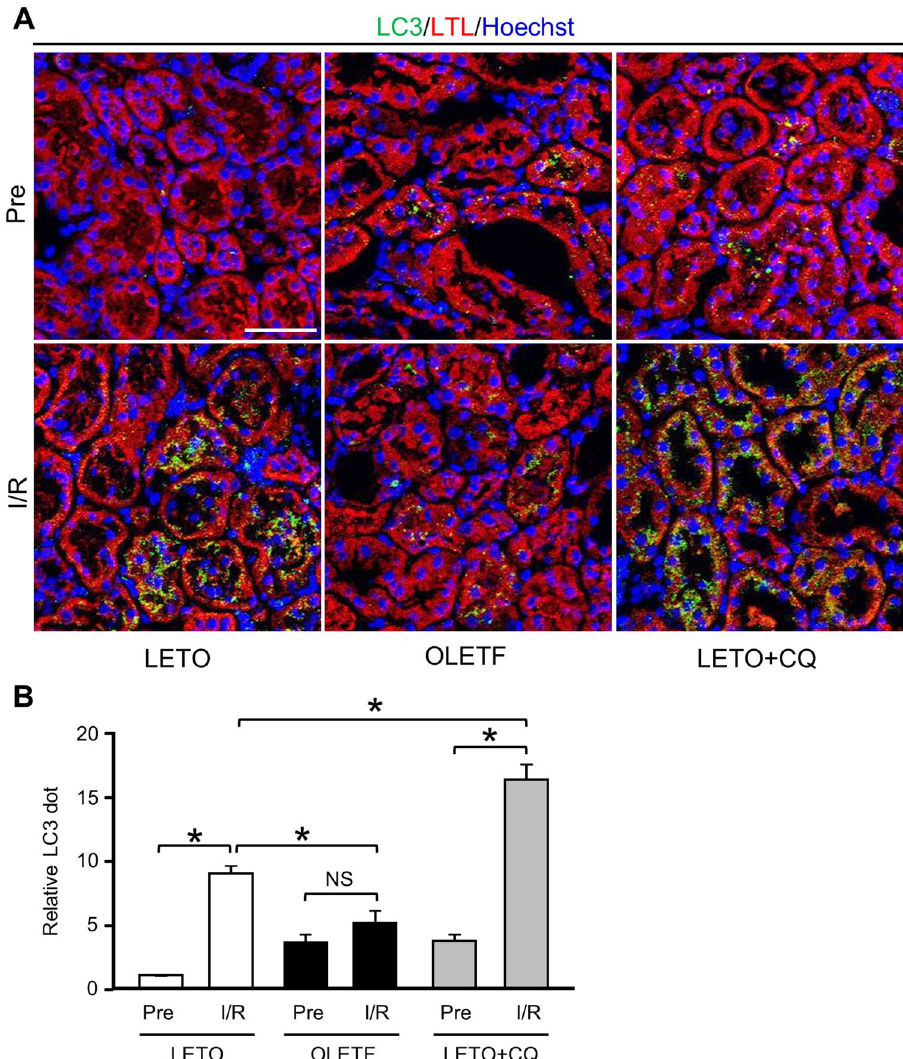
Figure 2. Autophagic response in proximal tubular cells after ischemia/reperfusion was attenuated in OLETF. ( A ) Representative immunofluorescence images of LC3 (green) and the proximal tubular marker lotus tetragonolobus lectin conjugated with Texas Red (LTL; red) in the kidneys of LETO, OLETF, and LETO treated with chloroquine (LETO + CQ). Nuclei were stained with Hoechst33342. Pre: pre-ischemia, I/R: 24 h after ischemia/reperfusion. ( B ) Summary data of LC3 dot numbers. N = 4 in each group. * P < 0.05, NS = not significant. Scale bar, 50 μ